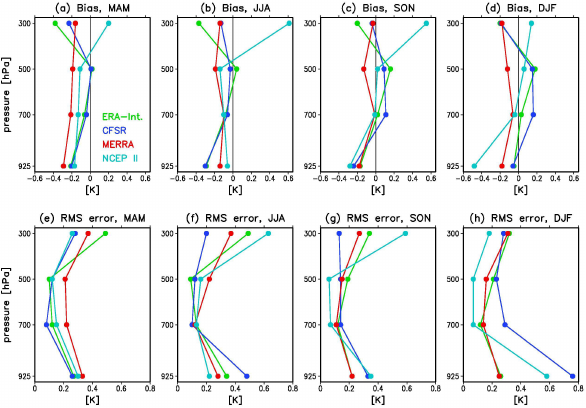
Fig. 8. Evaluation of the reanalyses with the IGRA data in June– August 2000–2009 average 925hPa T . The reanalysis data used here match the available IGRA observations in location and time. Shown is reanalysis temperature bias at each IGRA station in units of K, with the circle size indicating the magnitude of the bias. When the bias is positive (negative), the circle is colored red